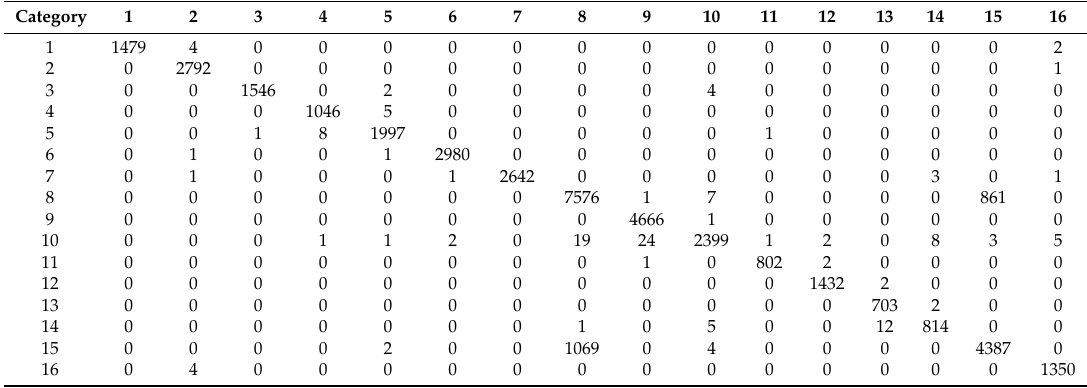
Table 13. Confusion matrix for maximum overlap pooling CNN classification used Salinas dataset.